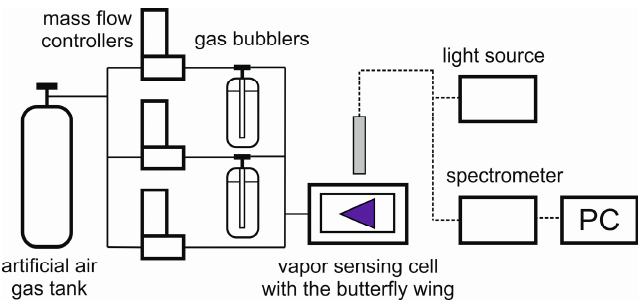
Figure 2. Schematic drawing of the measurement setup used in the vapor sensing experiment.